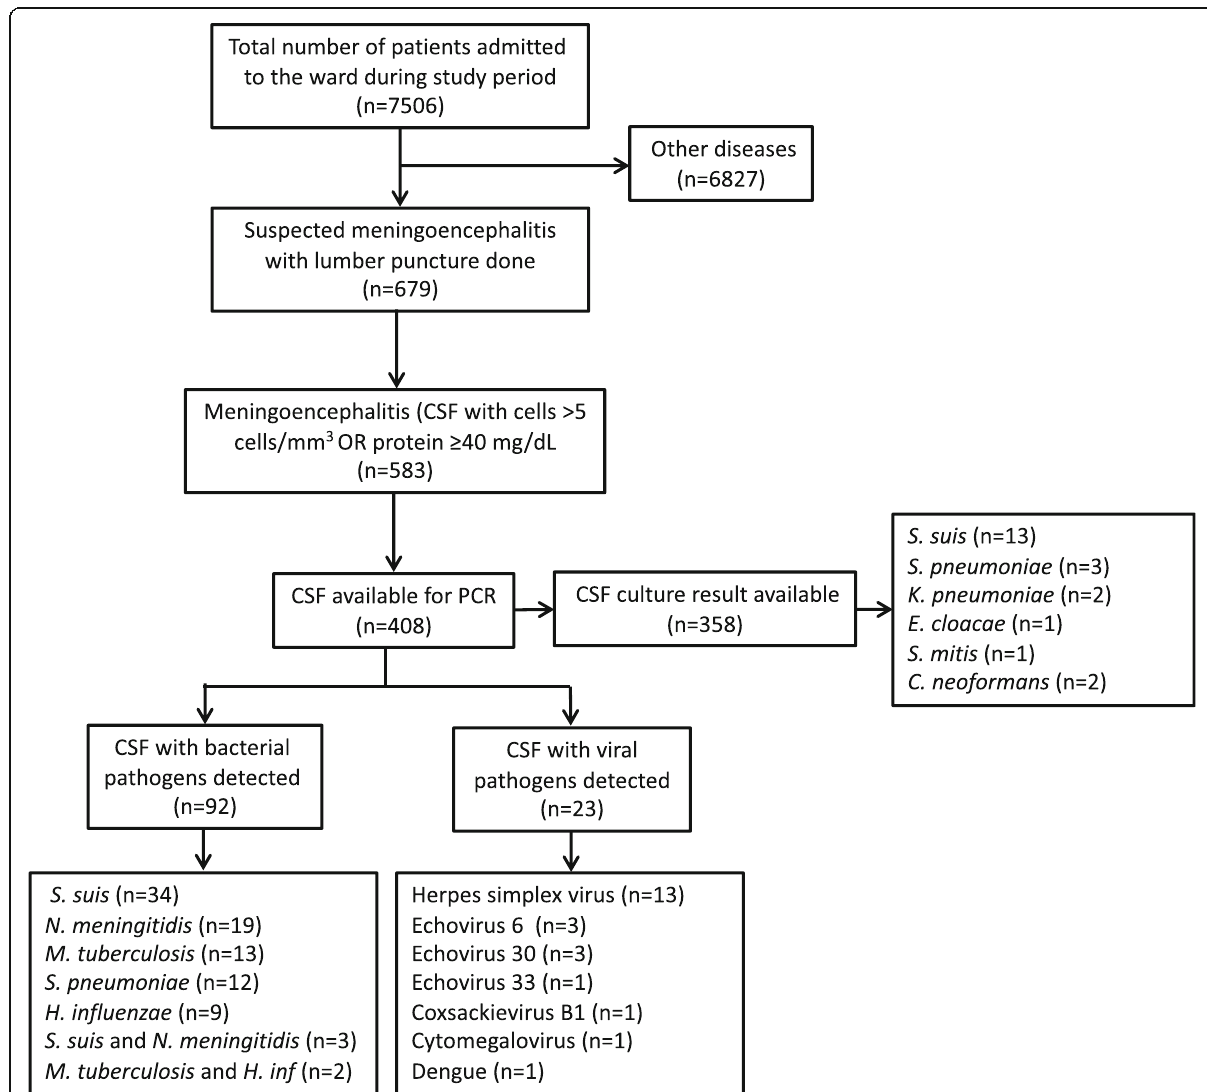
Fig. 1 Flowchart of the study showing the number of patients admitted to the ward during the study period to the detection of various pathogens in